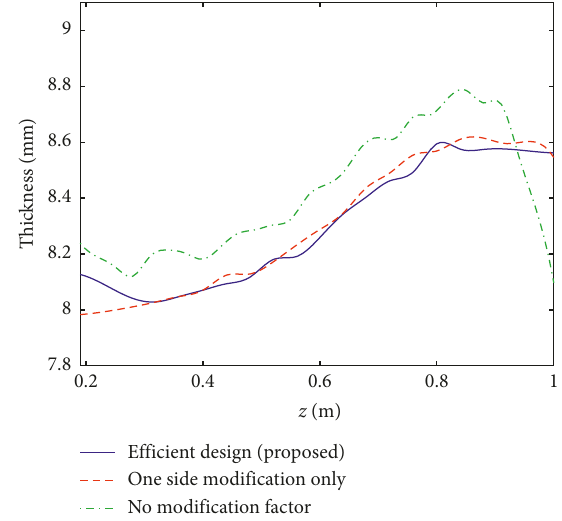
Figure 10: Thickness profile of VTRs obtained by the proposed method, one-side-correction-only method, and no-modification- factor